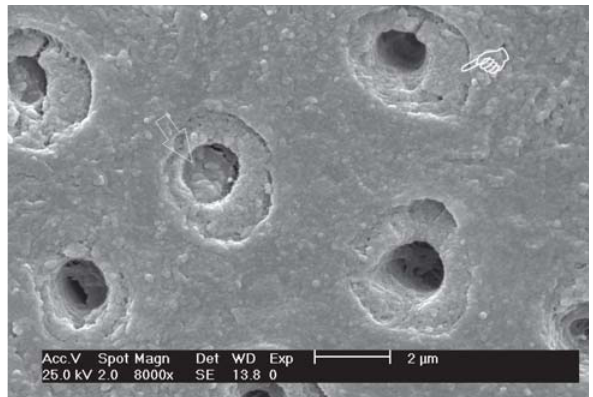
FIGURE 7- SEM micrograph of group 3 (iBond) - Lateral view of dentin tubules. Observe a totally opened (arrow) and a occluded dentinal tubule (x8,000)